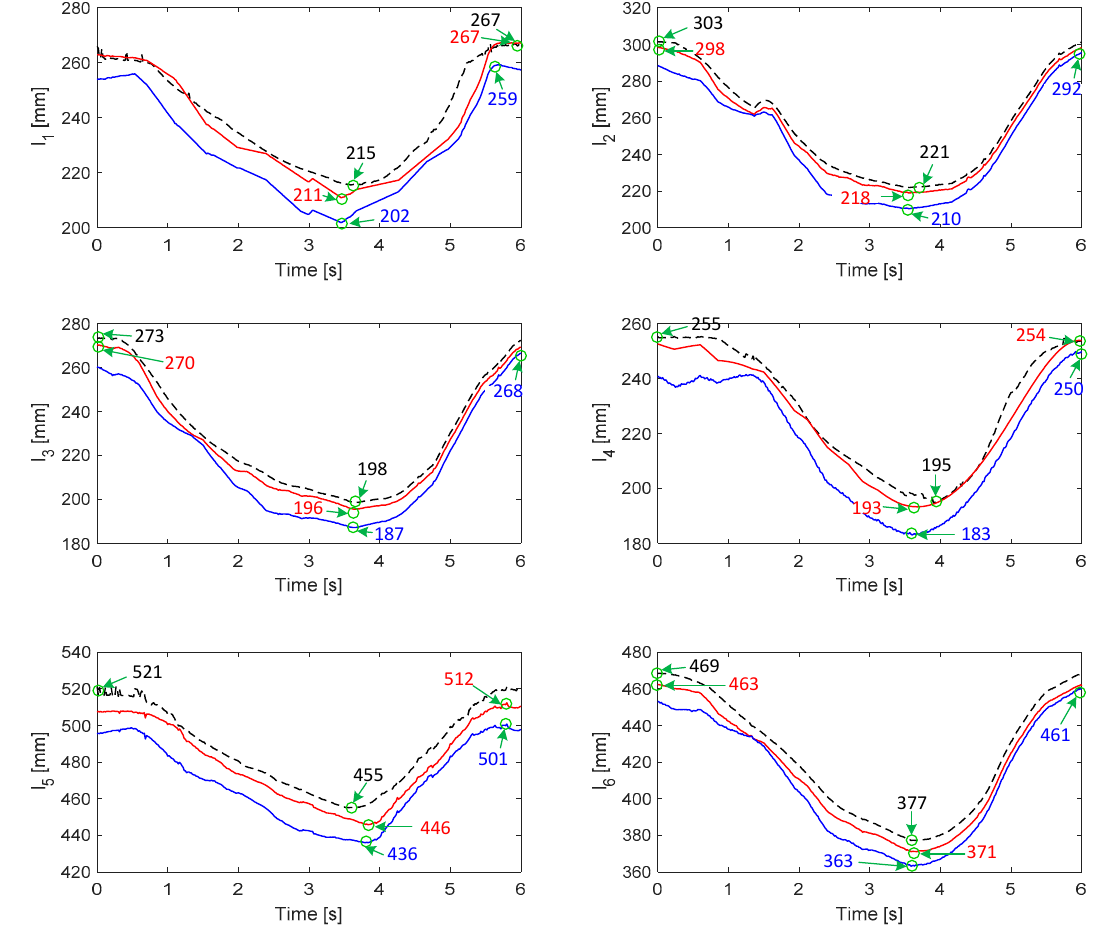
Figure 8. Changes of cables lengths in the experiment. The dotted lines denote the results obtained from the motion capture system. The red solid lines denote the calculated cables lengths based on the kinematic model with parameter identification; the blue solid lines denote the calculated results based on the kinematic model without parameter identification. Table 3. RMS errors of l i between captured results and calculated results based on identified/unidentified models.